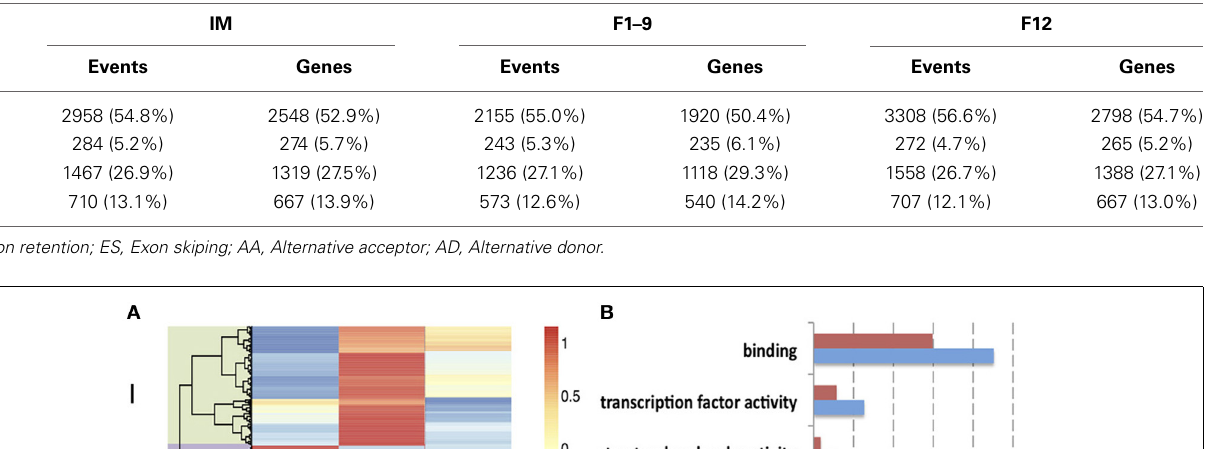
Table 3 | Summary of the four types of alternative splicing events of the three development stages.